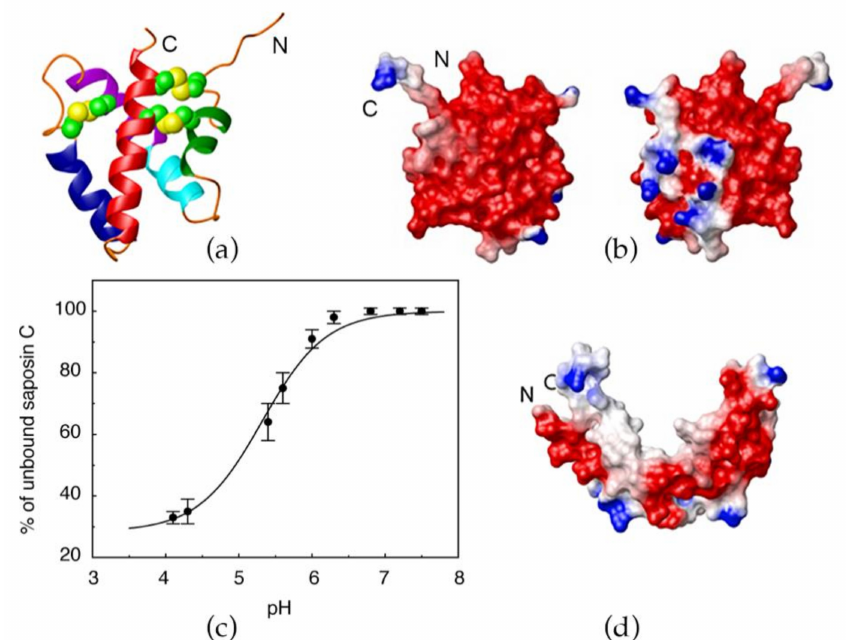
Figure 1. SapC binding to liposomes is a pH-dependent reversible process: ( a ) Ribbon diagram of the 3D NMR structure of sapC [9]; ( b ) Electrostatic surface charge distribution of sapC; ( c ) SapC reversible binding to liposomes with pH; ( d ) 3D structure of sapC bound to micelles [10]. ( a – c ): Reprinted from Biochemistry 2003 , 42 , 14729–14740. Published 2003 American Chemical Society; ( d ): Reprinted from J. Mol. Biol. 2005 , 346 ,